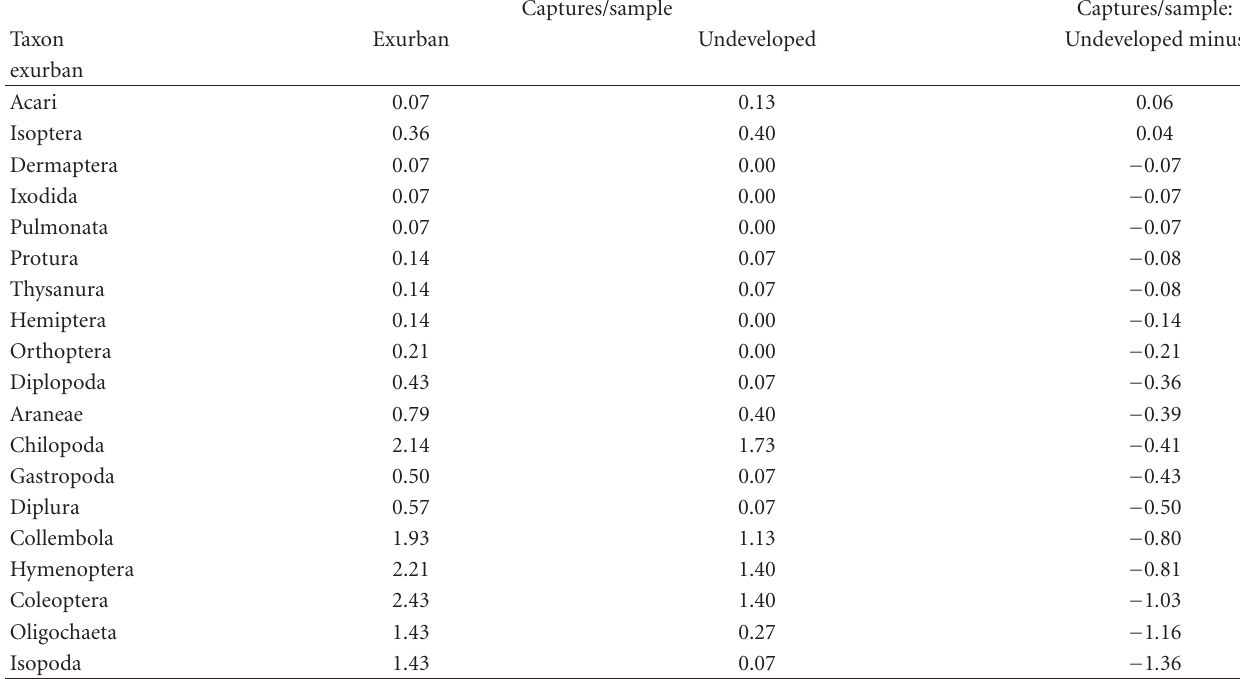
Table 2: Macroinvertebrate taxa detected from soil cores. Taxa are ranked according to the number of captures per sample point in undeveloped areas ( n = 15) minus the number of captures per sample point in exurban areas ( n = 14 points). Taxa with positive values of this di ff erence were found mostly undeveloped forests and not in exurban areas taxa with values near zero were found in both undeveloped forest and in exurban areas, and taxa with negative values were found mostly in exurban areas and not in undeveloped forest.